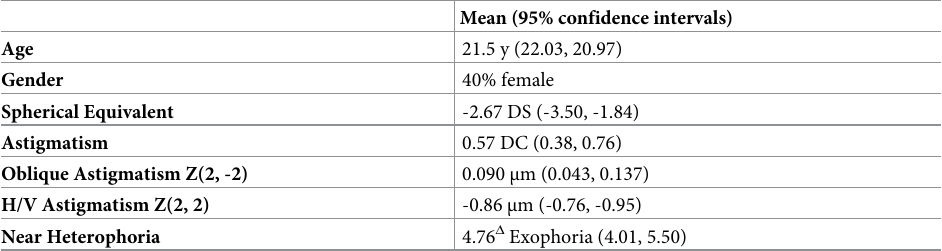
Table 1. Demographic and baseline information.